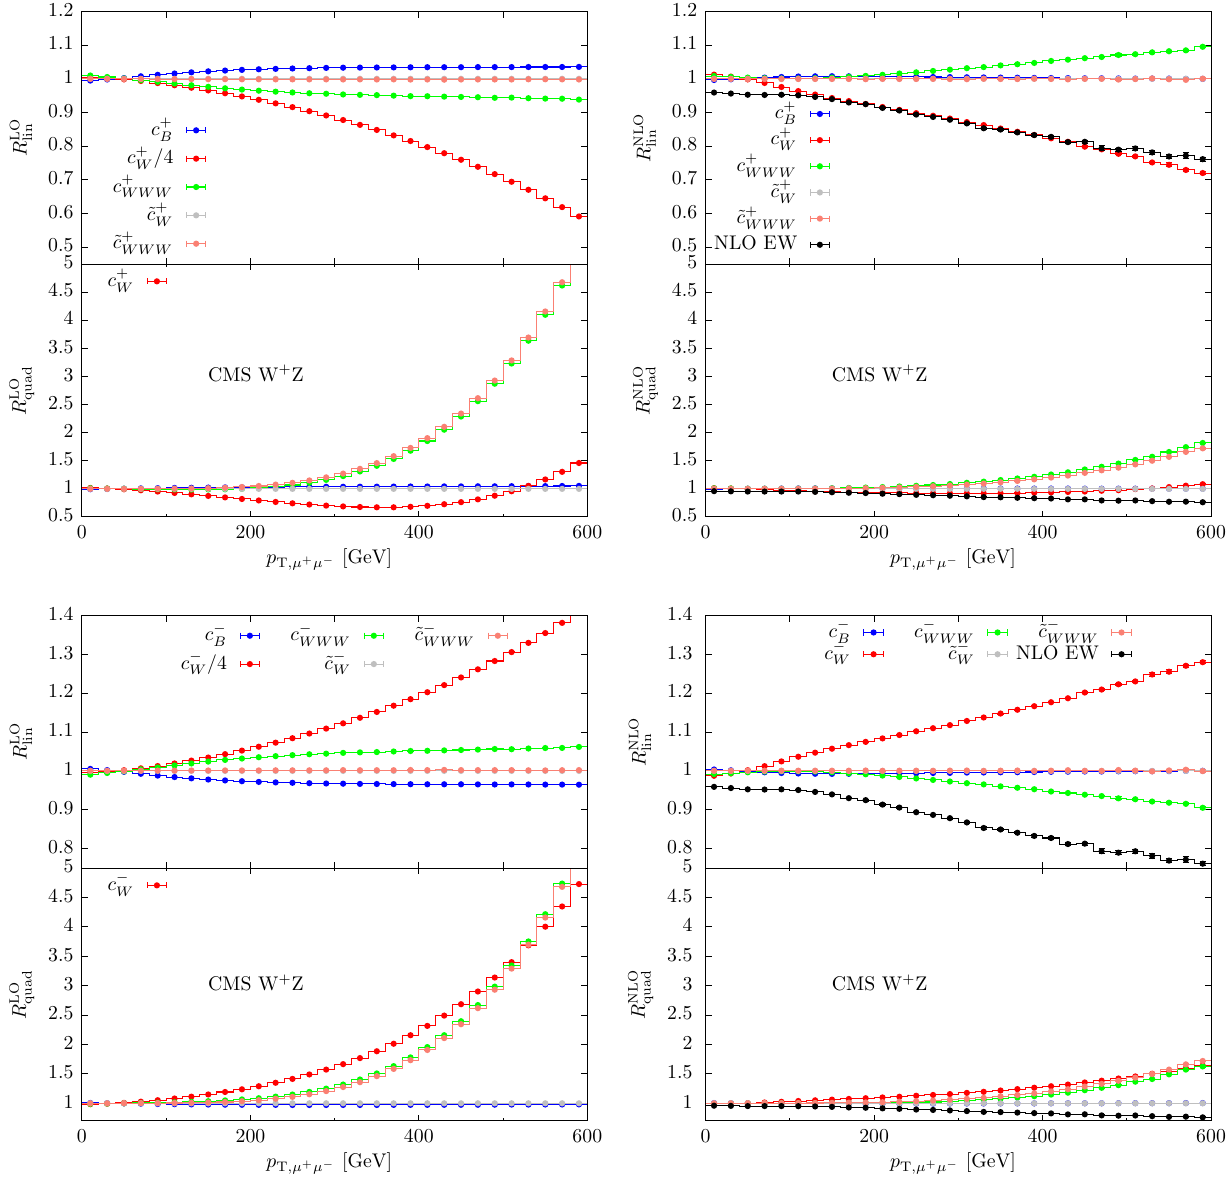
Fig. 13 Ratio R LO ( NLO ) as a function of the muon–antimuon trans- lin ( quad ) verse momentum for the process pp → e + ν e μ + μ − in the CMS setup of Eq. (4.8). Same notation and conventions as in Fig. 7. In order to